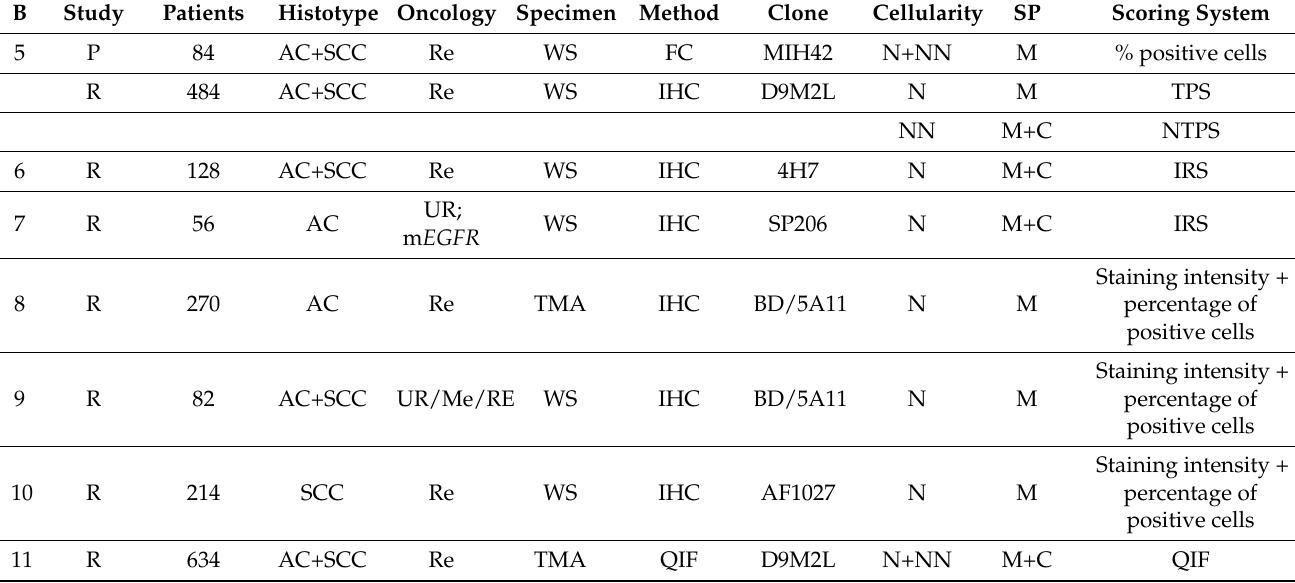
Table 1. Study on human NSCLC with clinicopathological findings and analytical methods